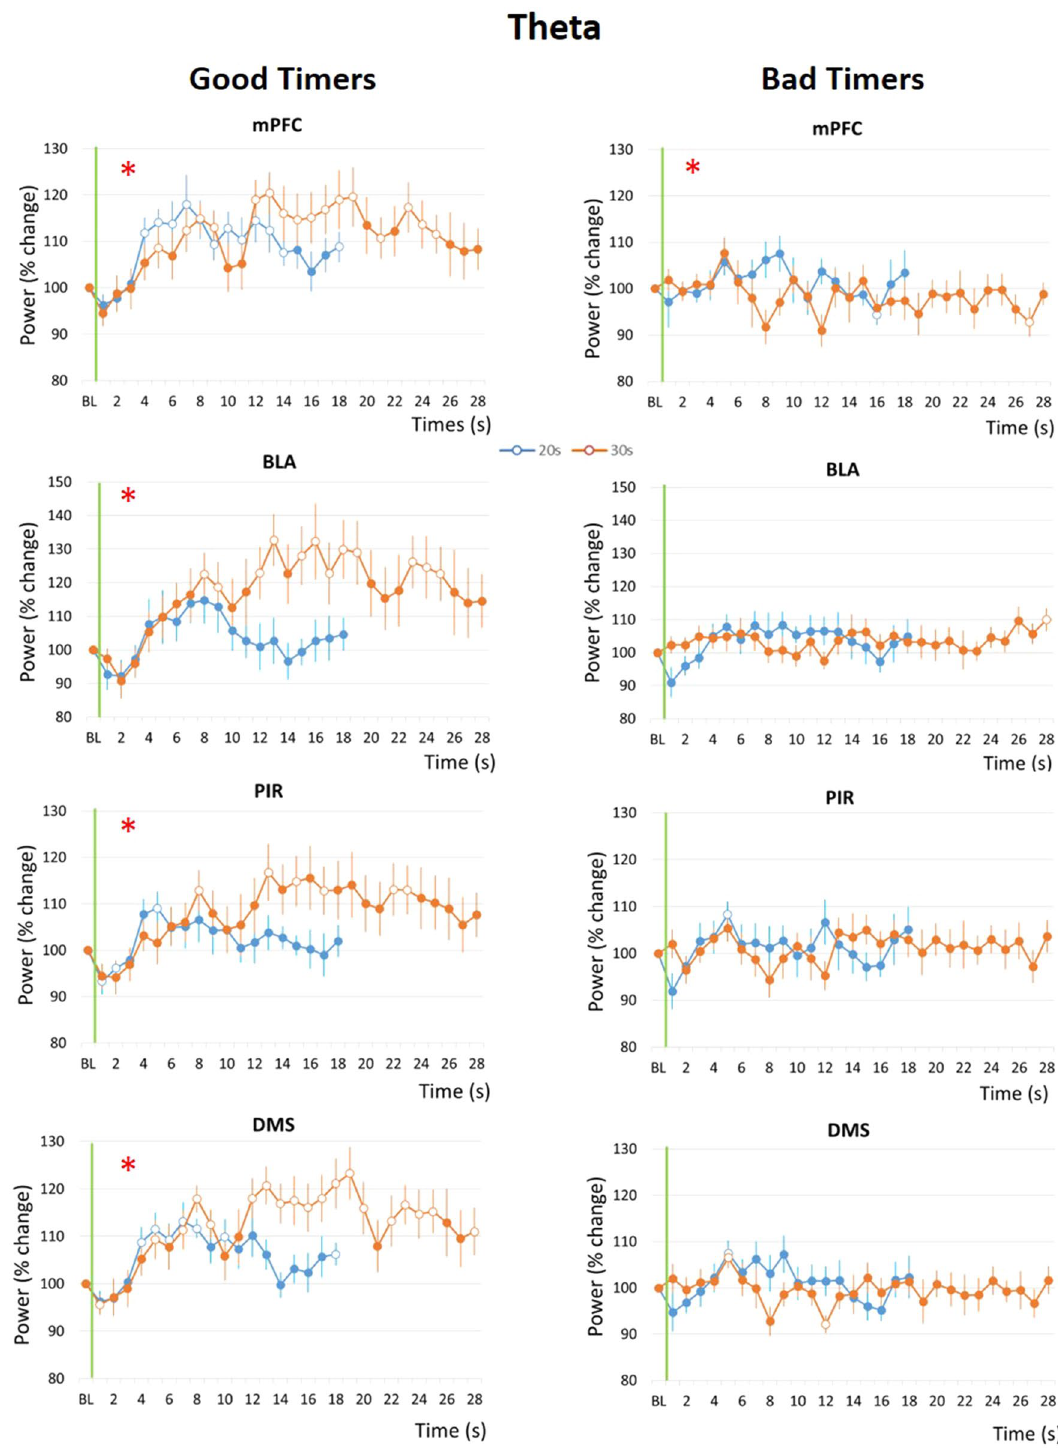
Figure 4. Theta (5–15 Hz) band mean power variations during the odor-shock interval in the Good Timers (left side) and Bad Timers (right side) subgroups in the four recording sites. mPFC medial prefrontal cortex, BLA basolateral amygdala, PIR olfactory piriform cortex, DMS dorso-medial striatum. For each graph, theta power was expressed as percent change from the baseline (BL), and represented from odor onset (green vertical line) to shock arrival which occurs either at 20 s (Conditioning session, in blue) or at 30 s (Shift session, in orange). The red asterisk in the upper left corner of a graph signals a significant time × interval duration interaction. Open circles on each curve signal the values that are significantly different from the baseline (p ≤